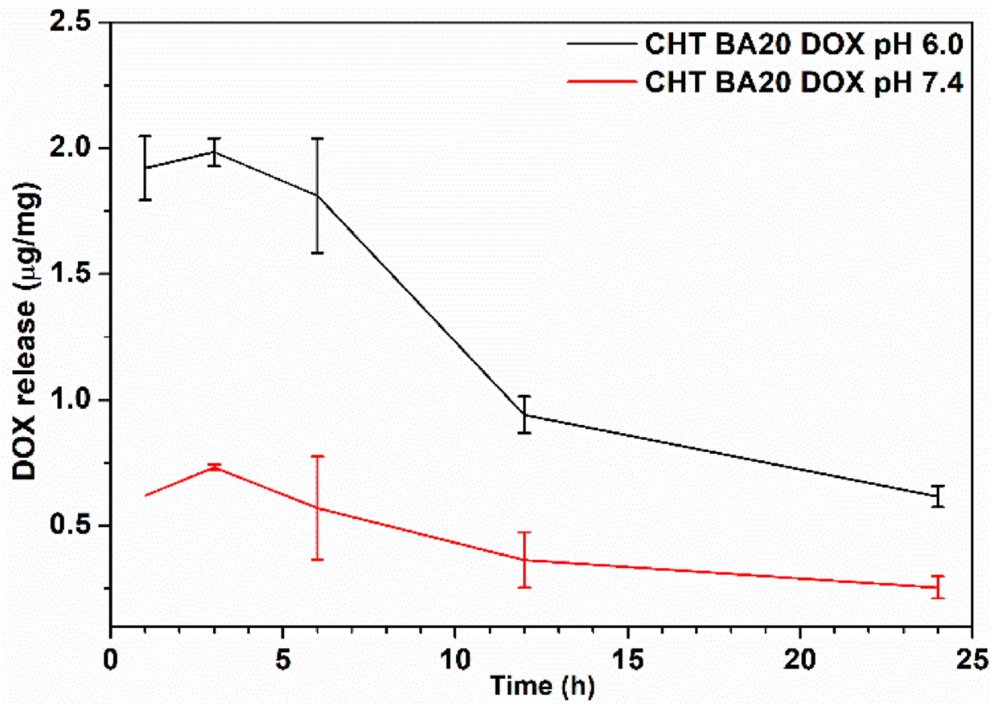
Figure 5. In vitro release of DOX from CHT BA scaffold in PB with different pH at 37 ◦